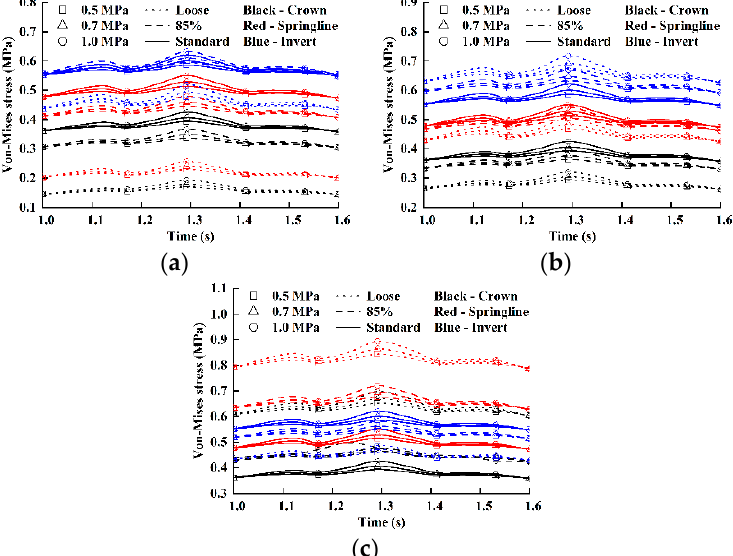
Figure 11. The Von-Mises stress under different load magnitudes: ( a ) change in L1 compaction degree; ( b ) change in L2 compaction degree; ( c ) change in L3 compaction degree.